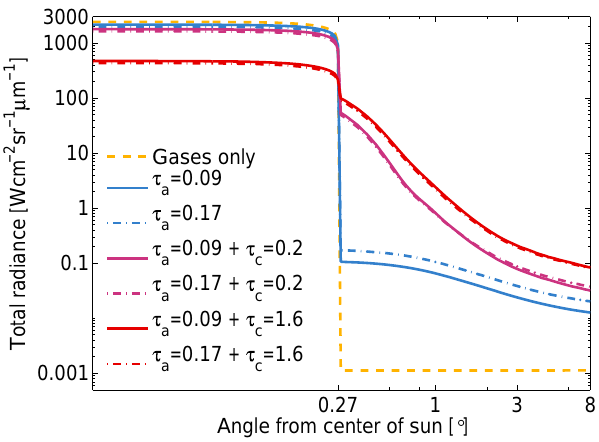
Figure 6. Impacts of the aerosol and cloud optical thicknesses on the simulated radiances as a function of angle from the center of the sun out to 8 ◦ . Atmospheric and aerosol properties are based on flight A with either τ a = 0 . 09 or τ a = 0 . 166. The cloud is described with the large A distribution of large SR ice crystals using two cloud optical thicknesses, τ c = 0 . 2 and